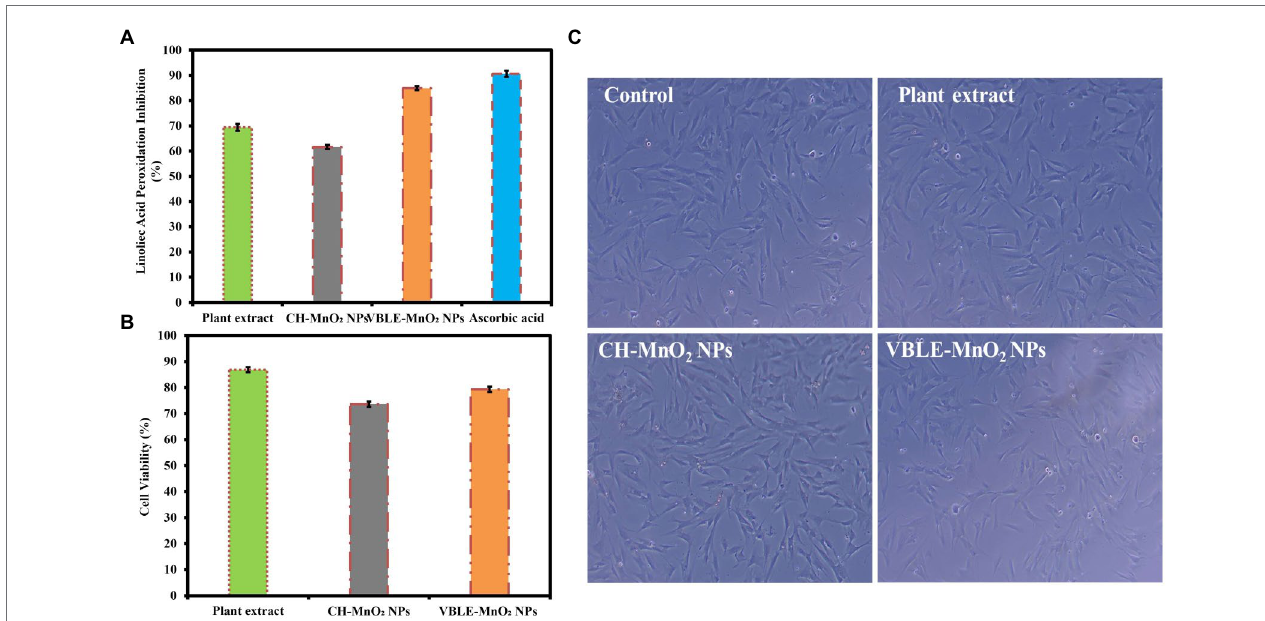
FIGURE 11 | (A) Antioxidant activity of the newly synthesized VBLE-MnO 2 NPs in comparison with V. betonicifolia leaves extract, CH-MnO 2 NPs, and external standard (Ascorbic acid). (B,C) Biocompatibility analysis of the newly synthesized VBLE-MnO 2 NPs with hMSC cells compared to the leaves extract of V. betonicifolia and CH-MnO 2